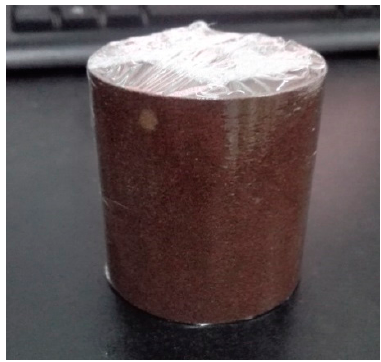
Figure 1. Maintenance of sample package.